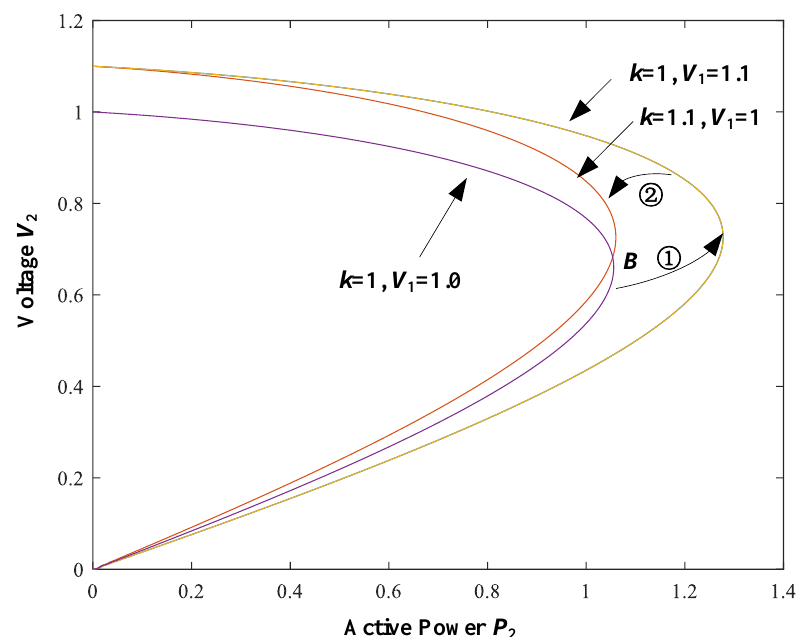
Figure 10. P-V curve of step and step-less voltage regulation with Flexible OLVR transformer. Point B is the intersection of two P-V curves.